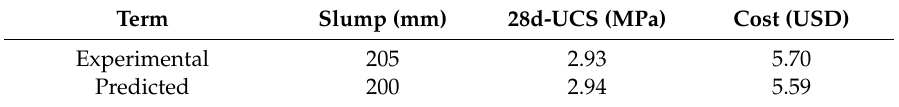
Table 9. Comparison between the experimental and predicted values of the optimized mixture. Term Slump